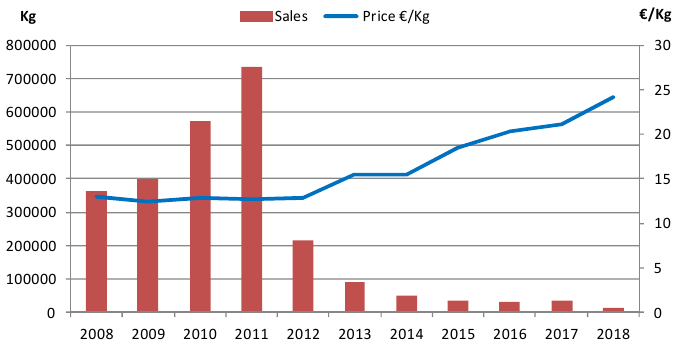
Figure 1. Sales and prices evolution of wreckfish in the Galician market from 2008 to 2018 [8].